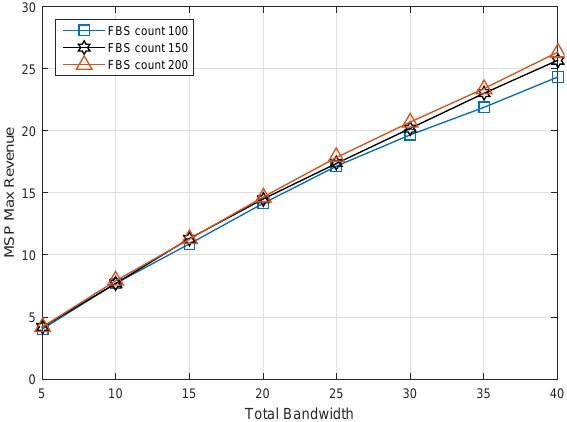
Figure 8. Max revenue of the MSP versus total bandwidth under different FBS